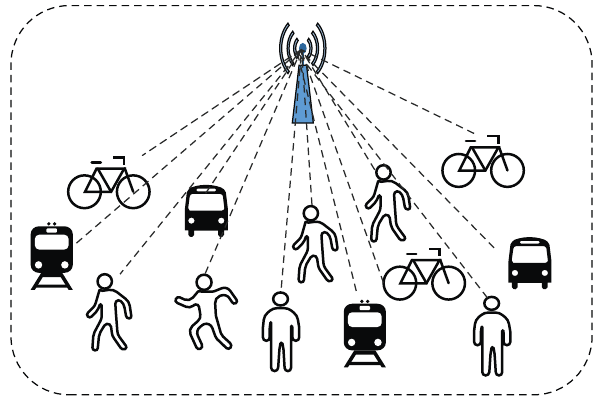
Figure 3: Using crowd-sourcing mode to collect transport states with the